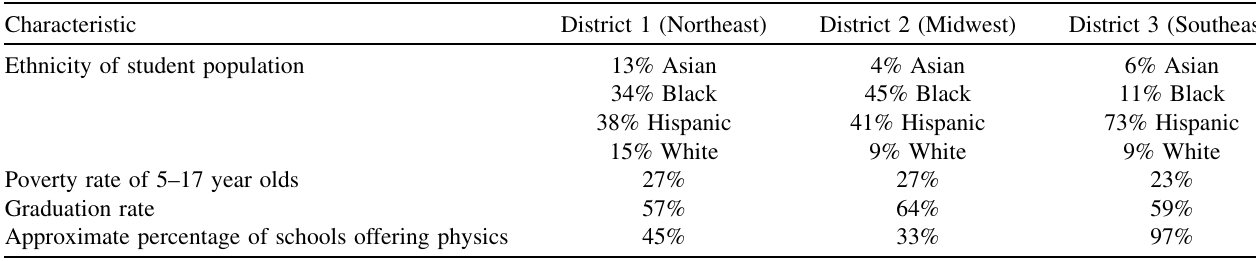
TABLE I. Demographic characteristics of urban school